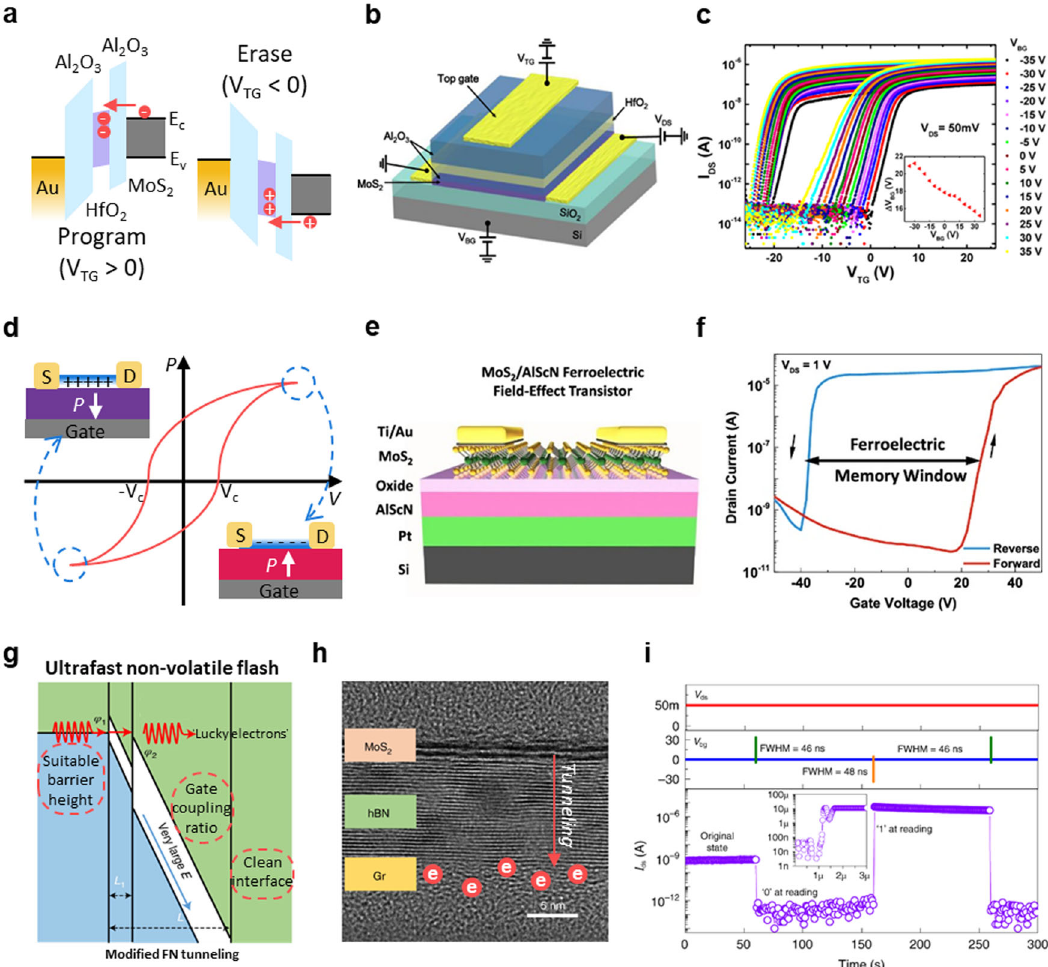
Fig. 7 2D semiconductors for memory. a Tunnelling mechanism of programing and erasing in a fl ash memory device. b Schematic structure of a charge-trap memory based on MoS 2 . c Memory window of the transfer curves in the MoS 2 memory device. b , c are reproduced from ref. 96 . d Illustration of polarization – voltage hysteretic characteristic in 2D ferroelectric fi eld-effect transistors. e Schematic structure of an AlScN/MoS 2 FE-FET. f Memory window of the transfer curves in the AlScN/MoS2 FE-FET. e , f are reproduced from ref. 108 . g Band alignment and the electric fi eld of 2D ultrafast non-volatile fl ash in the FN tunnelling process. h The cross-sectional high-resolution TEM image of the